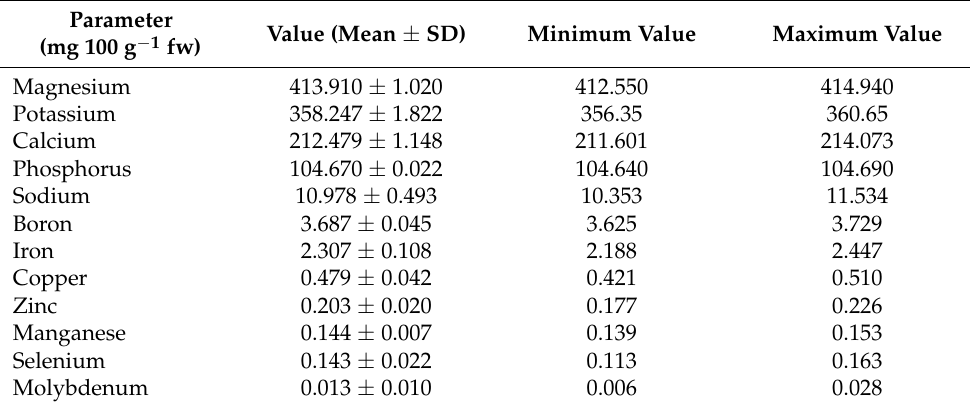
Table 10. Individual minerals for fresh weight of hackberry fruits (mean ± SD, minimum and maximum value, n =